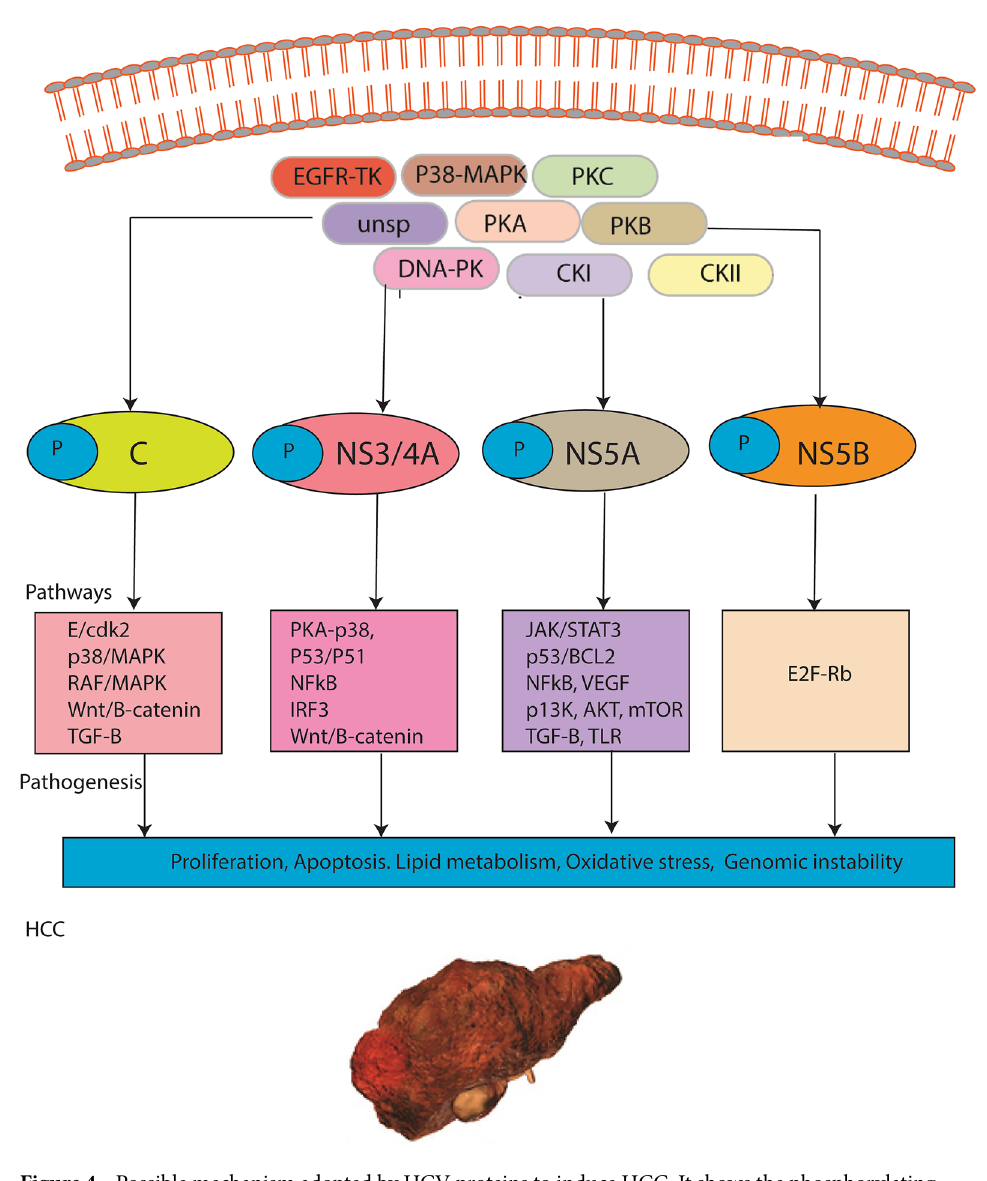
Figure 4. Possible mechanism adopted by HCV proteins to induce HCC. It shows the phosphorylating potential of various kinases (EGFR, p38-MAPK, PKC, unsp, PKA, PKB, DNA-PK, CKI and CKII) predicted through computation algorithms to phosphorylate HCV NS3/4A, NS5A and NS5B. This phosphorylation can support the viral proteins to initiate various pathways that lead to the development of